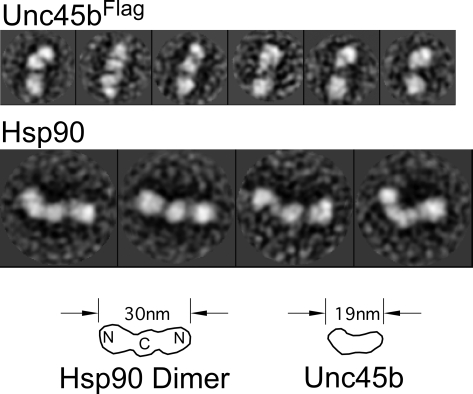
Gallery of Unc45b and Hsp90 molecules contrasted by rotary shadowing with platinum and imaged by electron microscopy.Each image is the class average of 25–50 particles that were selected by reference-free classification of several hundred individual particles and then aligned. These characteristic views of the 105 kDa Unc45b monomer reveal a molecule that is ∼19 nm long and 5 nm wide. Many images show at least two domains, but this interpretation is limited by the resolution of the rotary shadowing contrasting method. Class averages of Hsp90 dimers (∼180 kDa) are shown for comparison. Hsp90 is a 30 nm long dimer with a C-terminal dimerization domain and N-terminal ATPase domains linked by flexible regions.